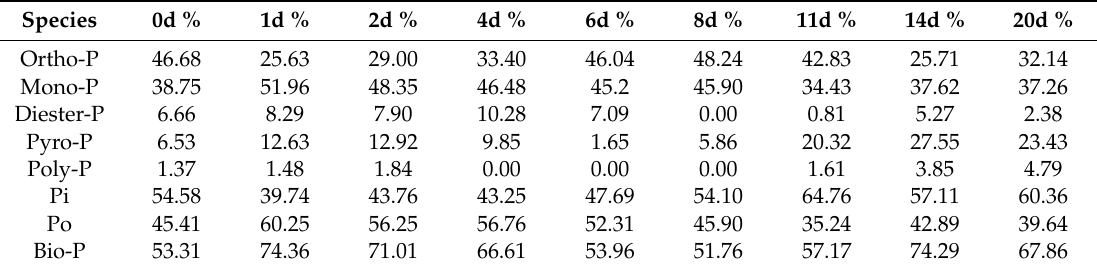
Figure 2. 31 P NMR spectra of PPOM (Water samples were taken and measured on days 0, 1, 2, 4, 5, 6, 7, 8, 11, 14, and 20). Table 2. Percentage of each P species in PPOM during PPOM degradation